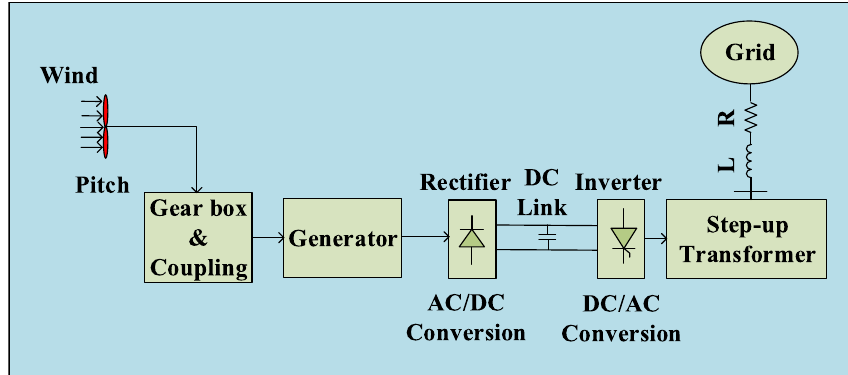
Fig. 8 Wind Energy Generation